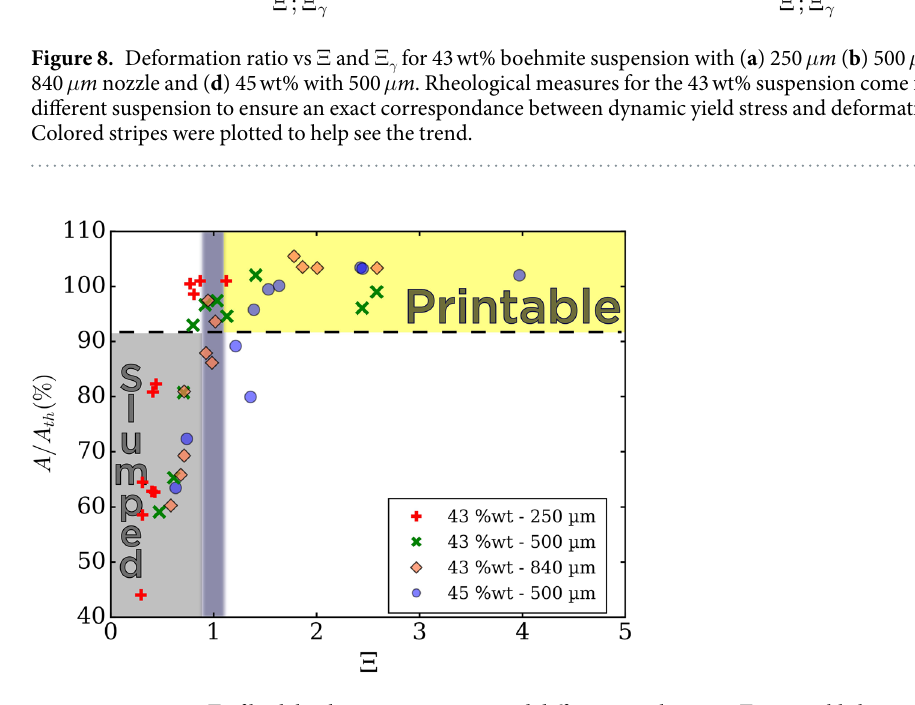
octan-1-ol ( Sigma-Aldrich ) per 100 mL of water were added as a defoaming agent to the boehmite suspensions used to print these samples. Microstructure. Images show that there are no visible printing defects in the core of the sample. The sample sur- face is embossed by the printing path as it can be seen on the sides of the image. Because of the alternate printing directionality, some layers are more protuberant than the others, such as it is possible to distinguish each printed